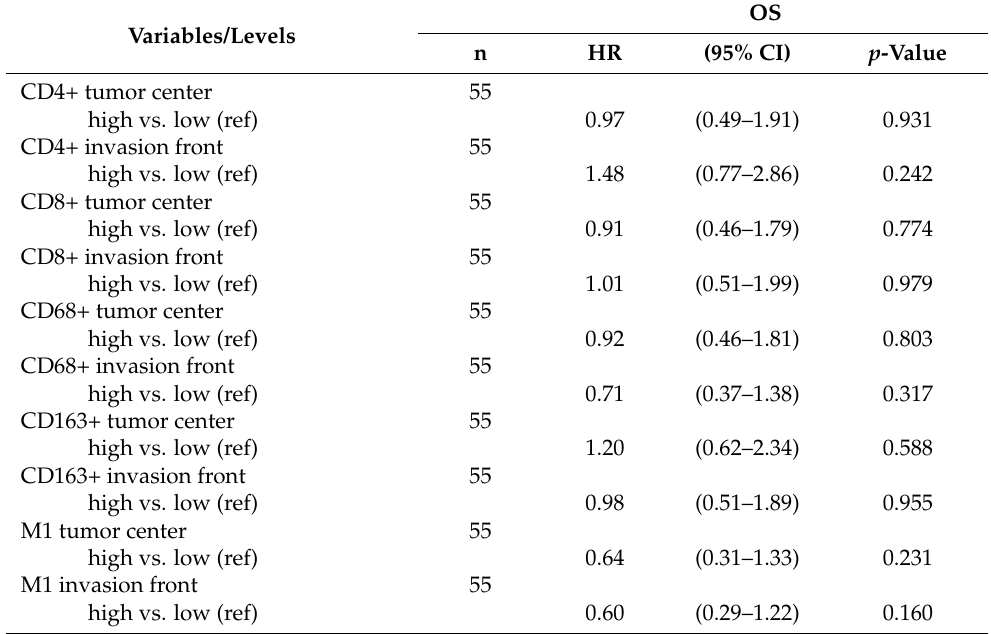
Table 4. Univariate Cox regression of all patient